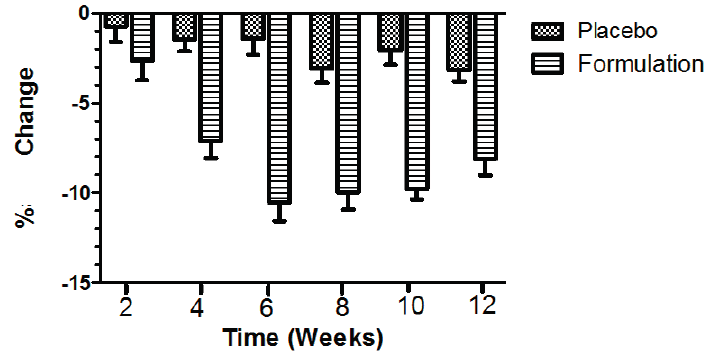
Figure 2. Percentage of change produced in transepidermal water loss (TEWL) values after application of placebo and active formulation in respective cheeks of volunteers ( n = 13). Bars represent mean standard deviation (s.d.) of three independent experiments. Statistical significance ( p ≤ 0.05) results were obtained between the second and 12th weeks, in favor of the active